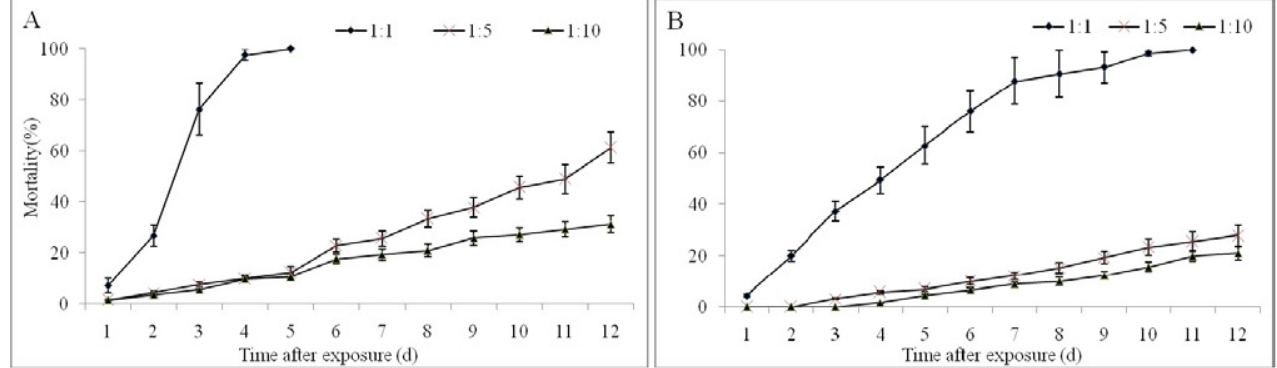
Fig 3. Average mortalities (± SE) of recipient C. formosanus at different donor-recipient ratios in the secondary transfer of 1% fipronil dust